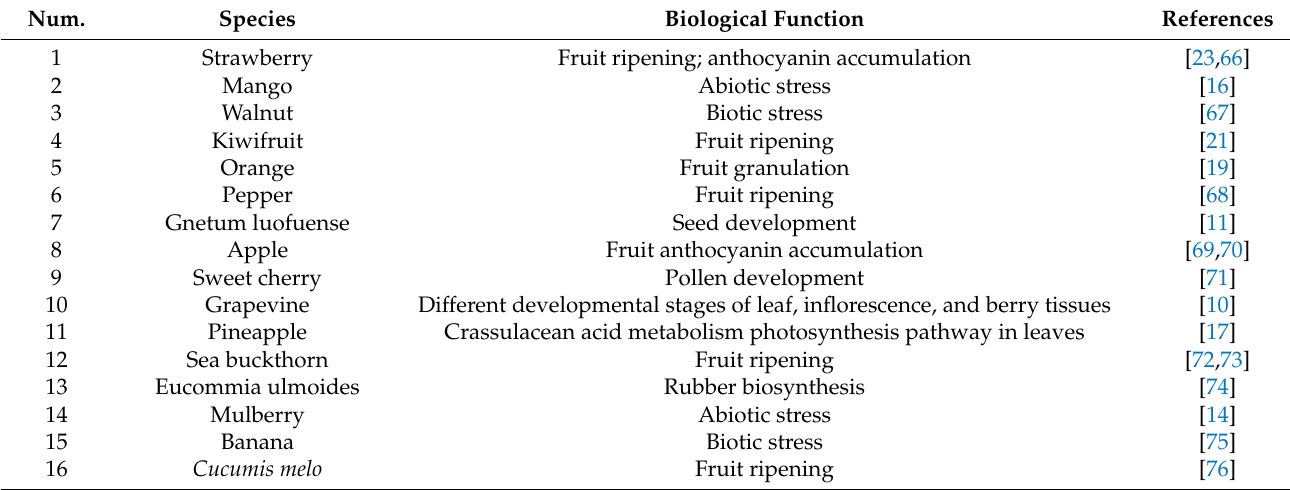
Table 2. Summary of studies on lncRNAs in horticultural